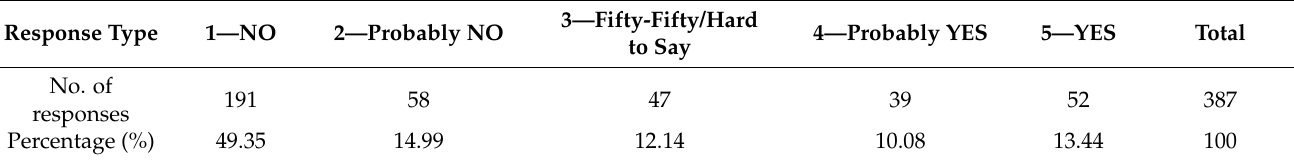
Table 9. Responses to the twelfth question: Do you know what ‘blockchain’